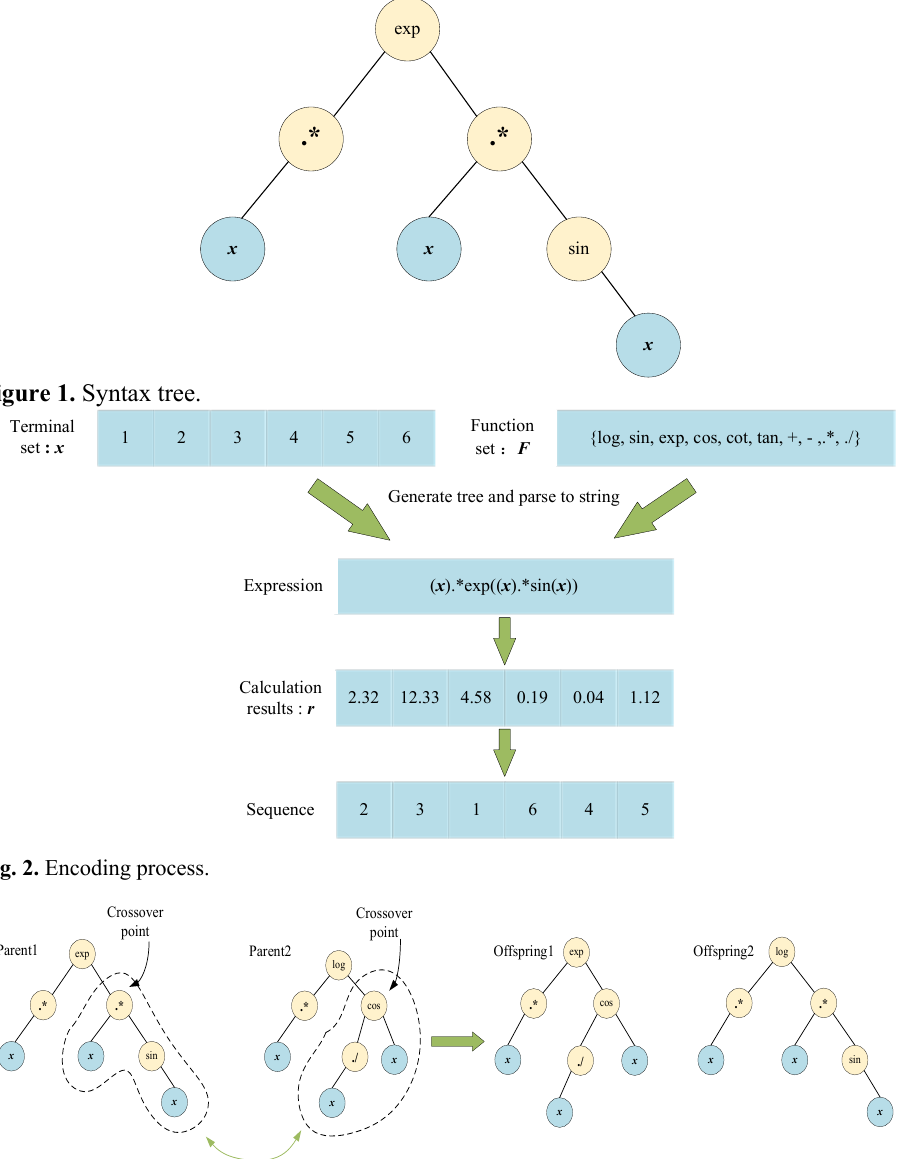
Fig. 3. Crossover